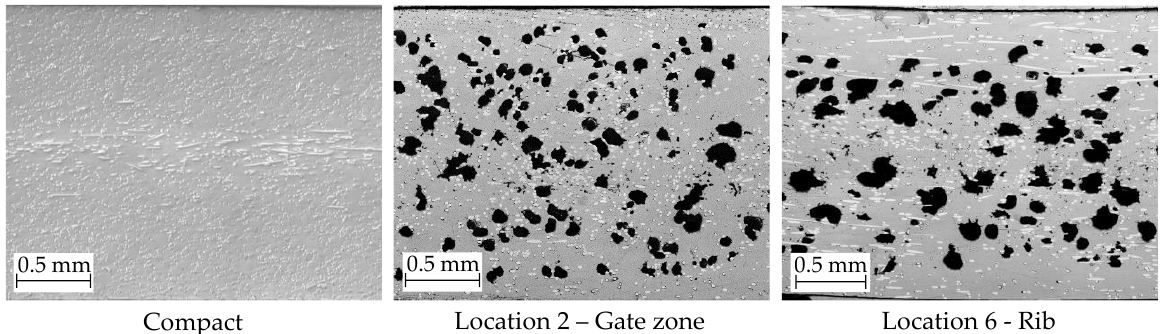
Figure 5. Microscopic images of cross-sections of compact and foamed sampling locations.